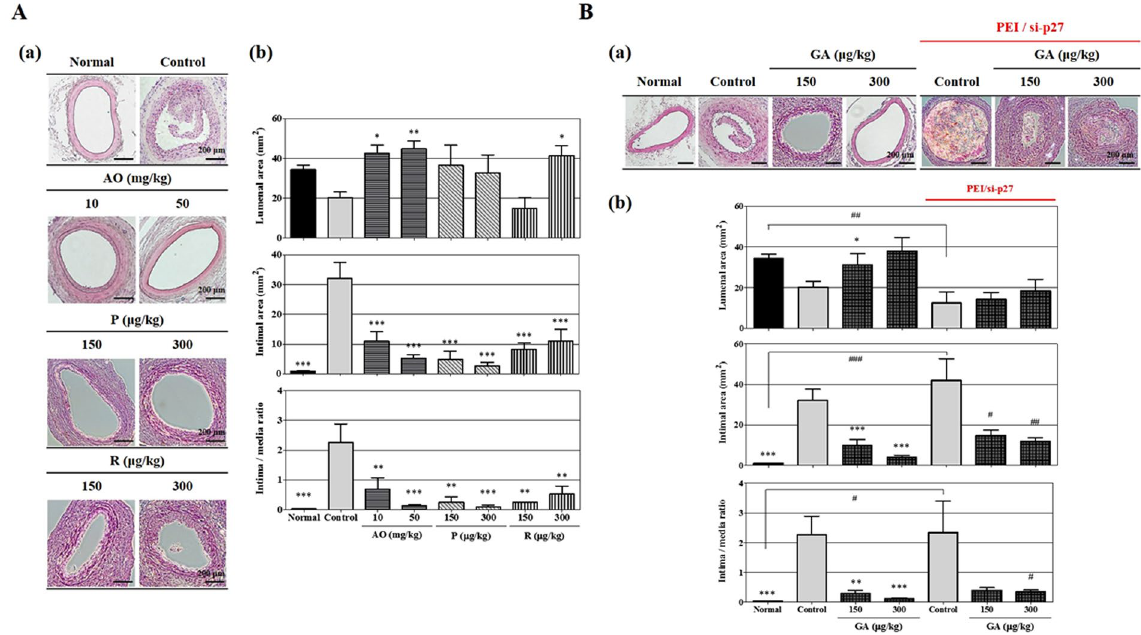
Figure 5. In vivo inhibitory effect of the AO extract and GA on VSMC proliferation in a cuff-injured neointimal hyperplasia model of the femoral artery. Rats were anesthetized with 2.5% isoflurane with supplementary O 2 gas and the femoral artery was exposed by dissecting the surrounding tissues. Neointimal hyperplasia of the femoral artery was induced by applying a cuff filled with 30% pluronic F-127 gel for 14 days. ( A ) The effects of the AO extract (10 and 50 mg/kg) were examined using hematoxylin-eosin (H&E) staining on the cuff-injured neointimal hyperplasia model, using the existing clinical medicines paclitaxel and rapamycin (sirolimus) (150 and 300 μ g/kg) as positive controls (a); the suppressive effects of the AO extract, paclitaxel, and rapamycin on the luminal area, intimal area, and intima/media ratio were then examined (n = 5) (b). ( B ) The effect of silencing p27 expression using in vivo -jetPEI ® on the anti-proliferative actions of GA (150 and 300 μ g/kg) in the cuff-injured neointimal hyperplasia model, showing H&E staining of the cuff-injured femoral artery (a), and its luminal area, intimal area, and intima/media ratio (b) (n = 6). Images are presented at their original magnification (300 × ; Aa and Ba), scale bar is 200 μ m. The values are expressed as the mean ± SEM. Significant differences relative to the cuff-injured control and cuff-injured control pretreated with the PEI and si-p27 complex are indicated by asterisks: * ,# P < 0.05, ** ,## P < 0.01, *** ,### P <